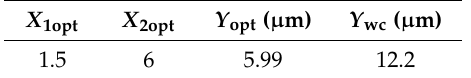
Table 5. Results of the DOE optimization.